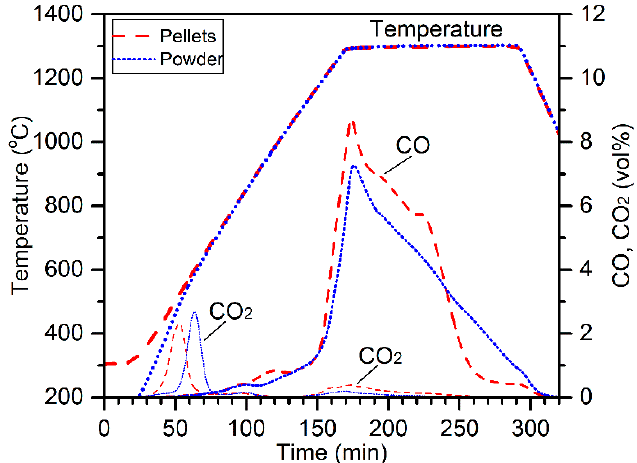
Figure 8. Temperature profiles and off-gas CO and CO 2 concentrations for the tests using pellets and powder.